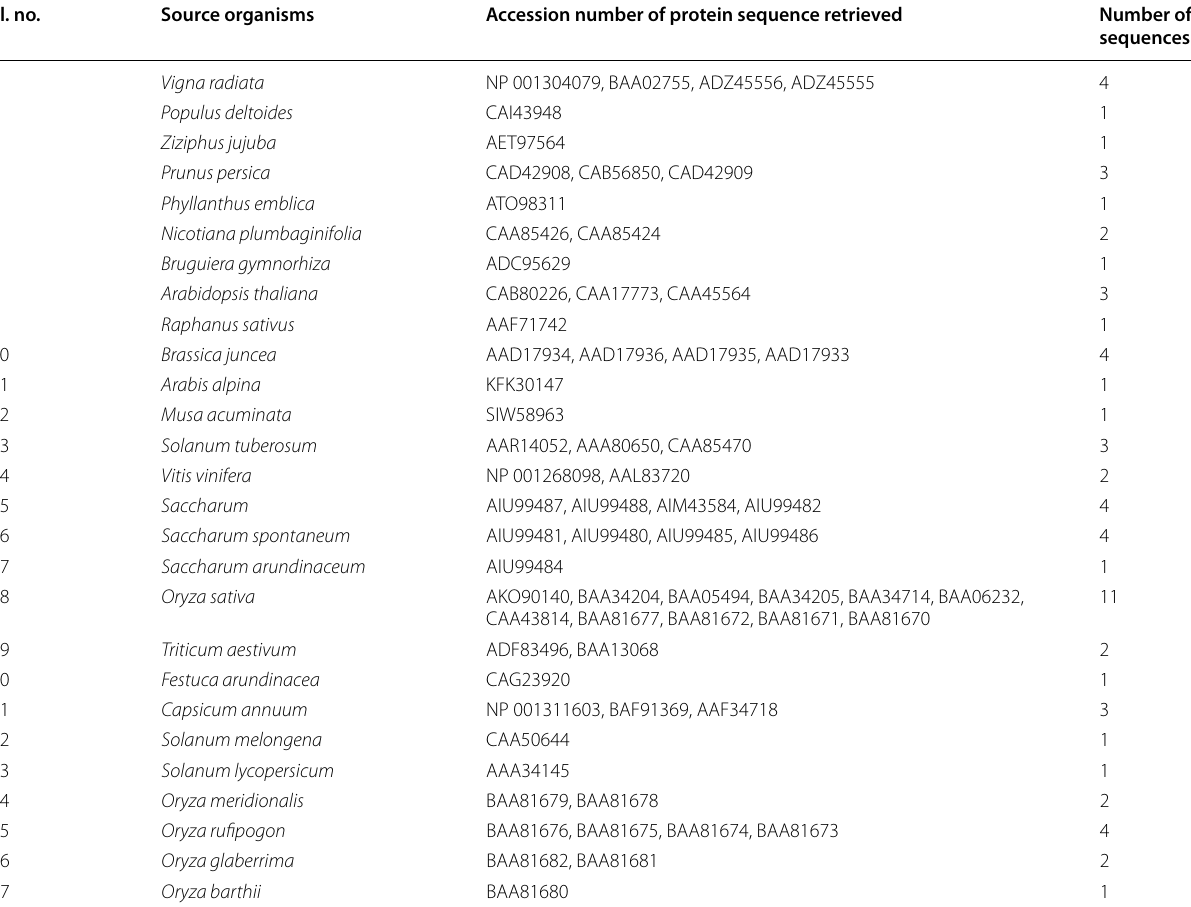
Table 1 Selected protein sequences of catalases from different plant sources Sl.